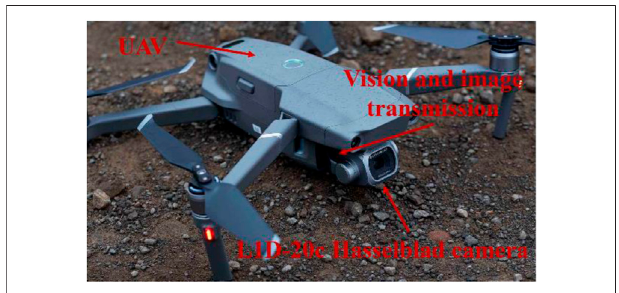
FIGURE 1 | The experimental data acquisition UAV of FFC surface chromatic